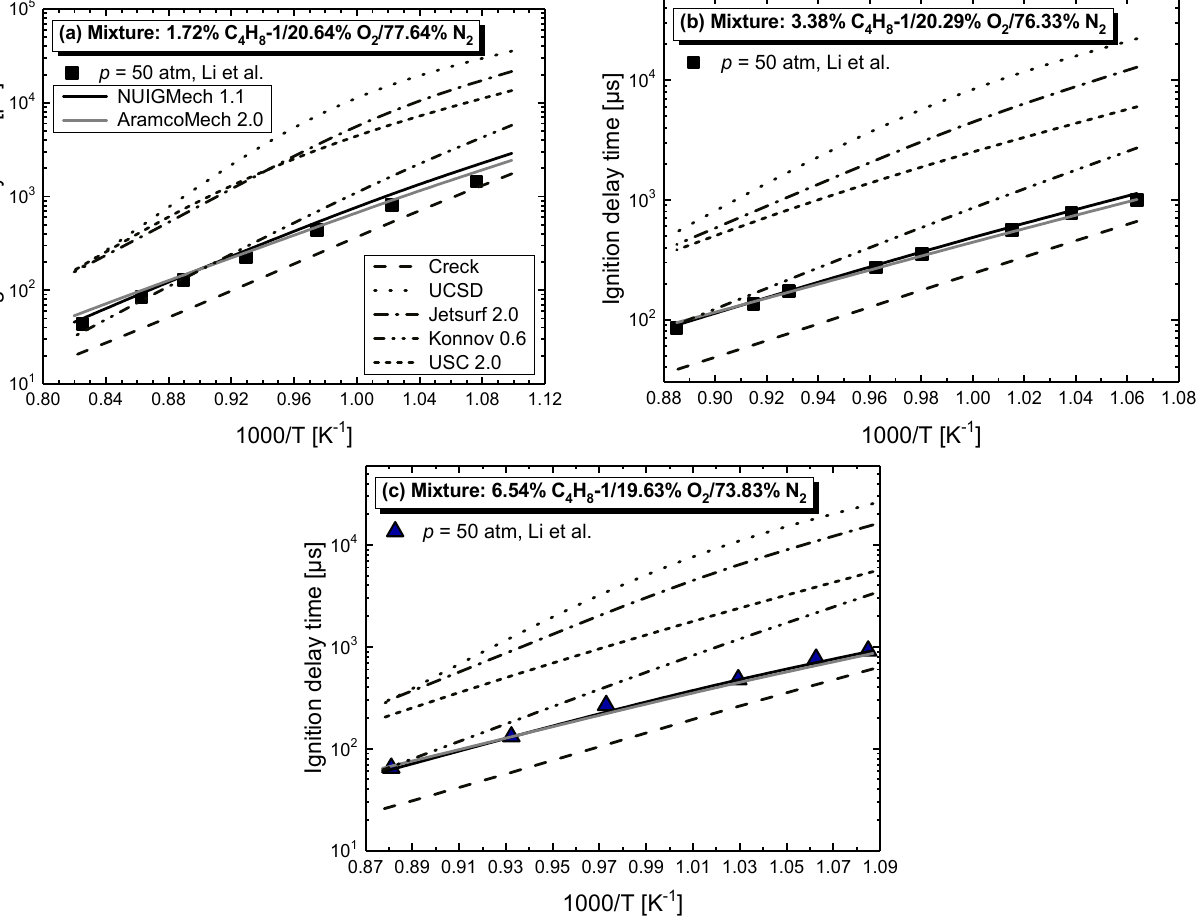
Figure 10. Comparison of measured and simulated IDTs of propene with RCM at f = 0.5 ( a ), f = 1.0 ( b ) and f = 2.0 ( c ). Symbols: experiments from Li et al. [43], lines: model simulations.